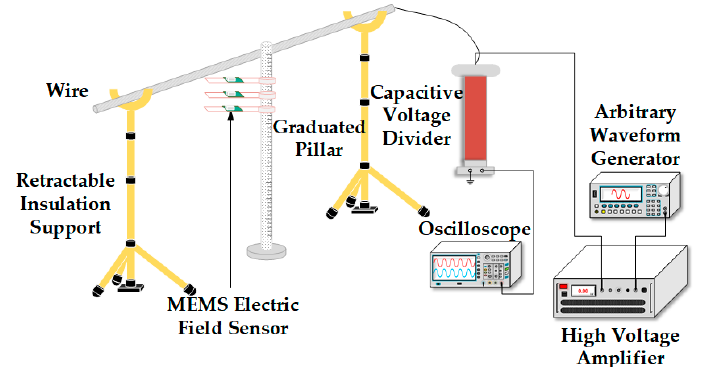
Figure 10. The non-intrusive voltage-measurement test platform for overhead lines.